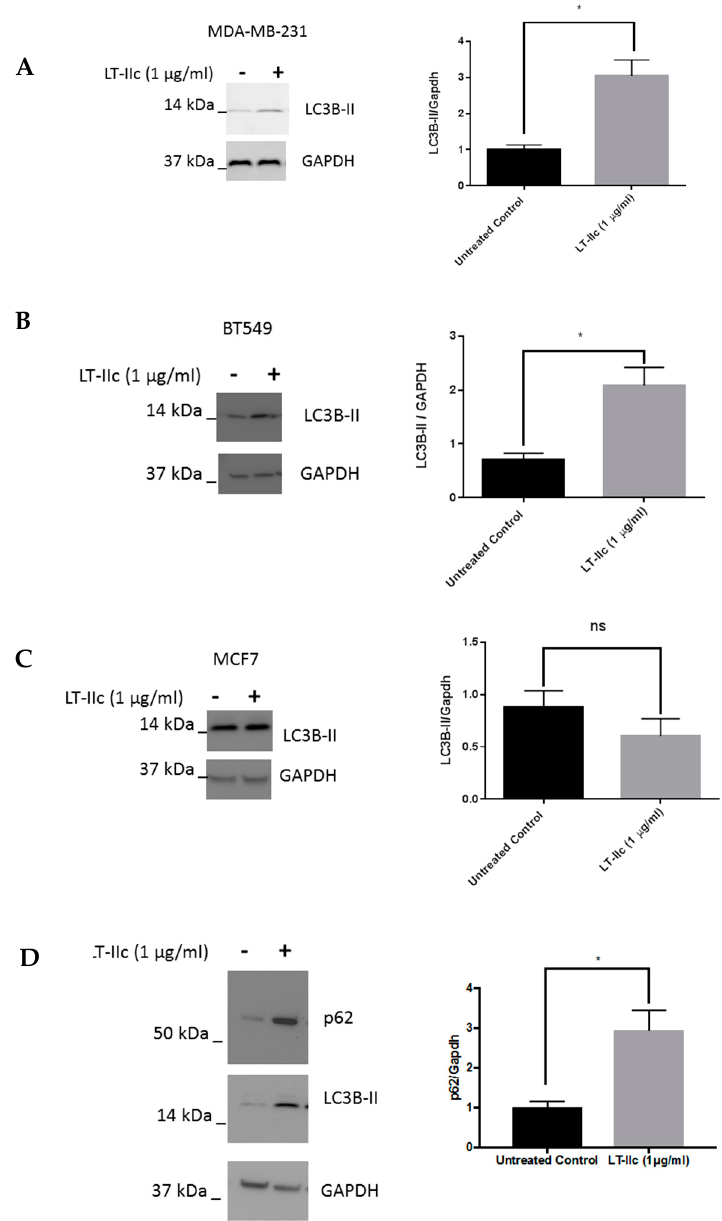
Figure 5. The effect of LT-IIc on autophagy in breast cancer cells. MDA-MB-231, BT549, and MCF7 cells were treated with 1 µg/mL LT-IIc for 24 h, prior to generating lysates for Western blotting. ( A ) Representative Western blot for LC3B-II with GAPDH as a loading control is shown ( N = 3 independent experiments) for MDA-MB-231 ( A ), BT549 ( B ), and MCF7 cells ( C ). ( D ) Lysates from MDA-MB-231 cells treated ±1 µg/mL LT-IIc were analyzed for the expression of p62 protein levels by Western blotting, using GAPDH as a loading control. Representative blot of three independent experiments. Quantitation of blots was performed using Image J. Error bars represent SEM. Key: * p < 0.05.